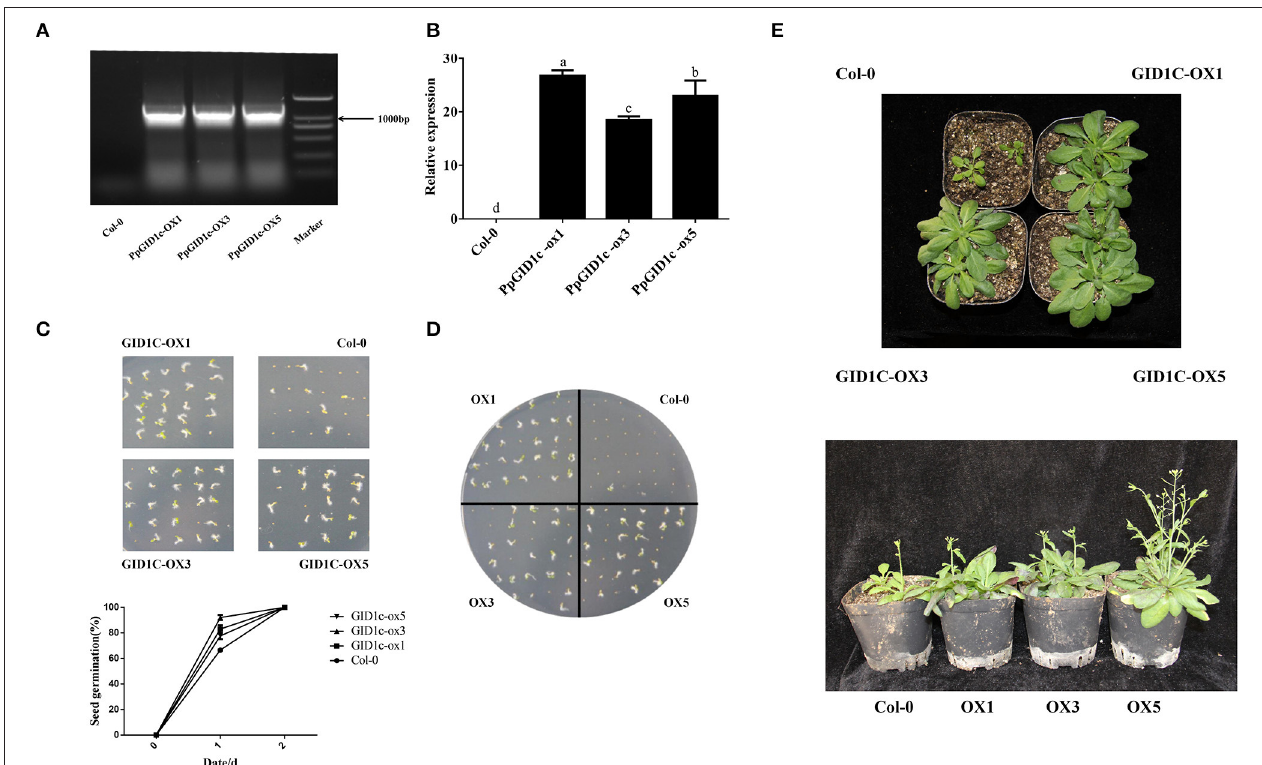
FIGURE 3 | PpGID1c transgenic Arabidopsis line overexpression identification. (A) PCR identification of T3 generation positive transgenic lines. (B) Quantitative real-time PCR (qRT-PCR) identification of T3 generation positive transgenic lines. (C) Determination of germination rate of Col-0 and PpGID1c transgenic Arabidopsis in an MS medium. (D) Determination of the germination rates of Col-0 and PpGID1c transgenic Arabidopsis seeds in MS + PAC. (E) Phenotyping of rosette leaves and flowering in Col-0 and PpGID1c transgenic Arabidopsis